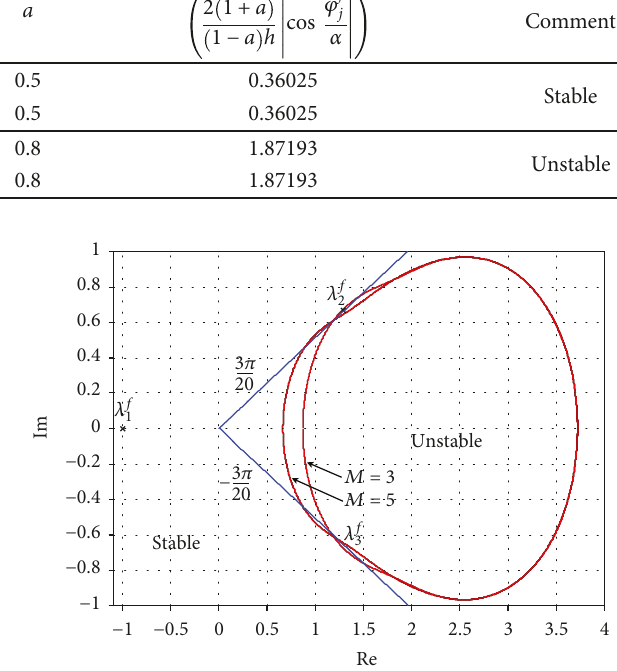
Figure 6: Stability/instability areas for di ff erent implementation lengths M ; Example